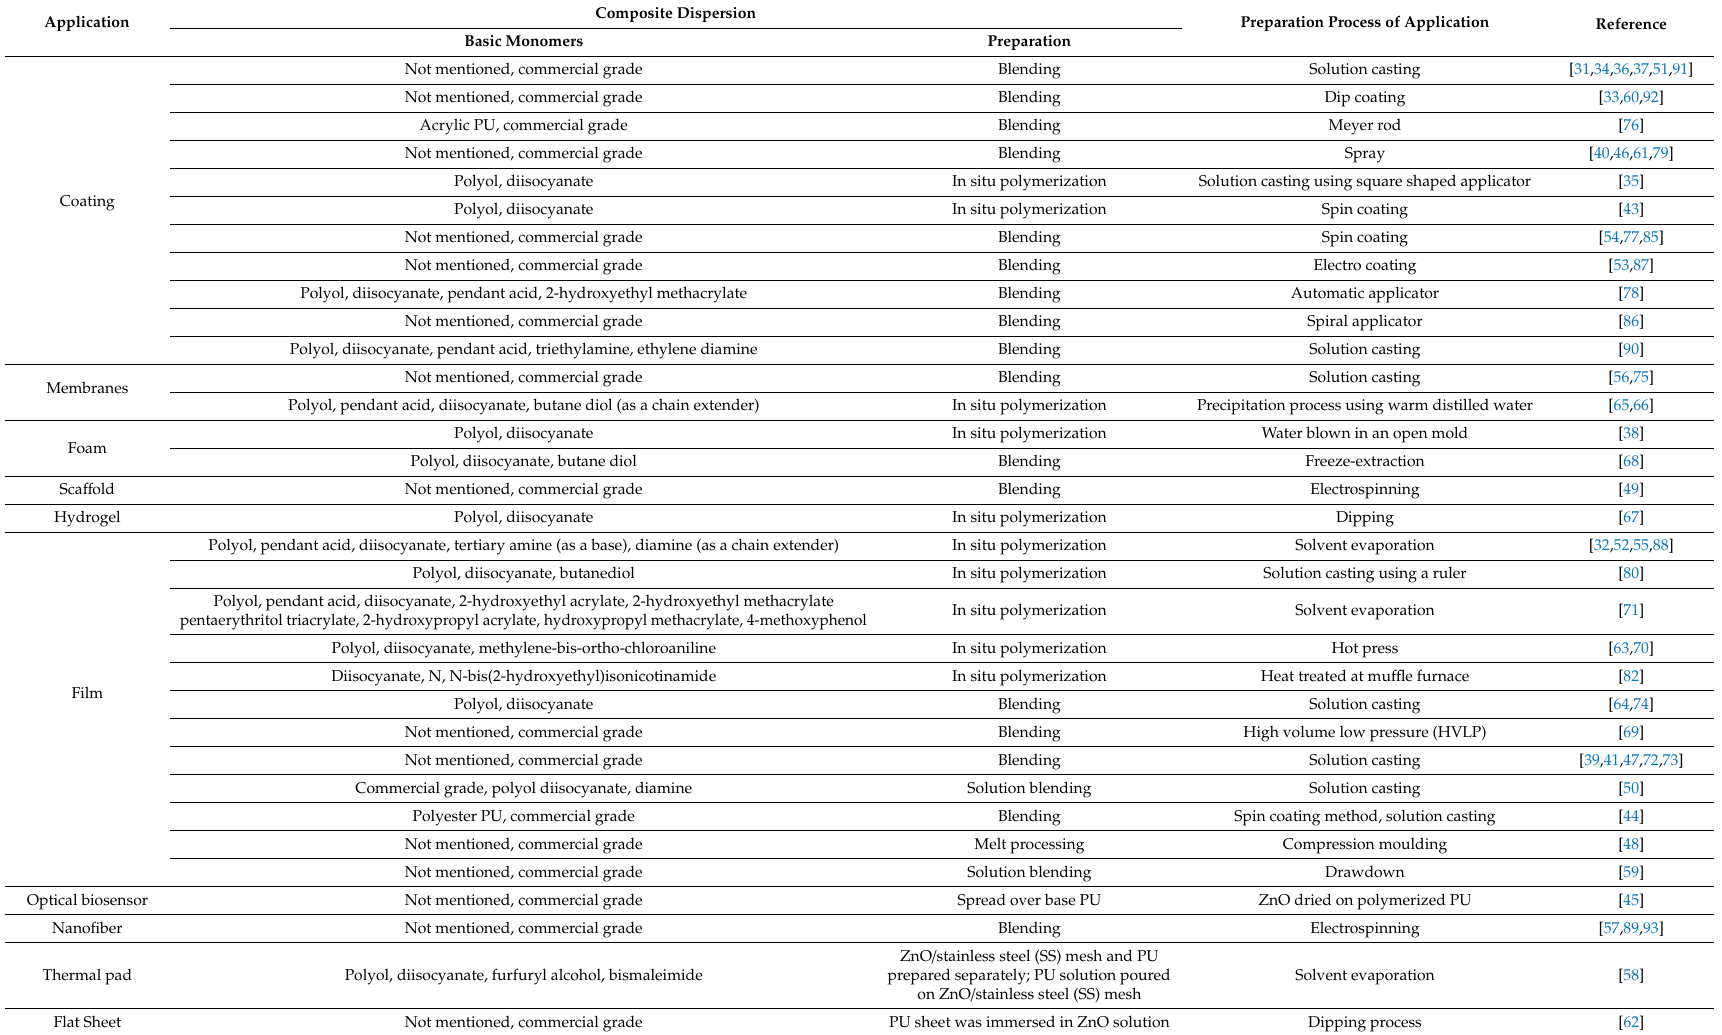
Table 1. Basic monomers, dispersion preparation methods and applications of PU / ZnO